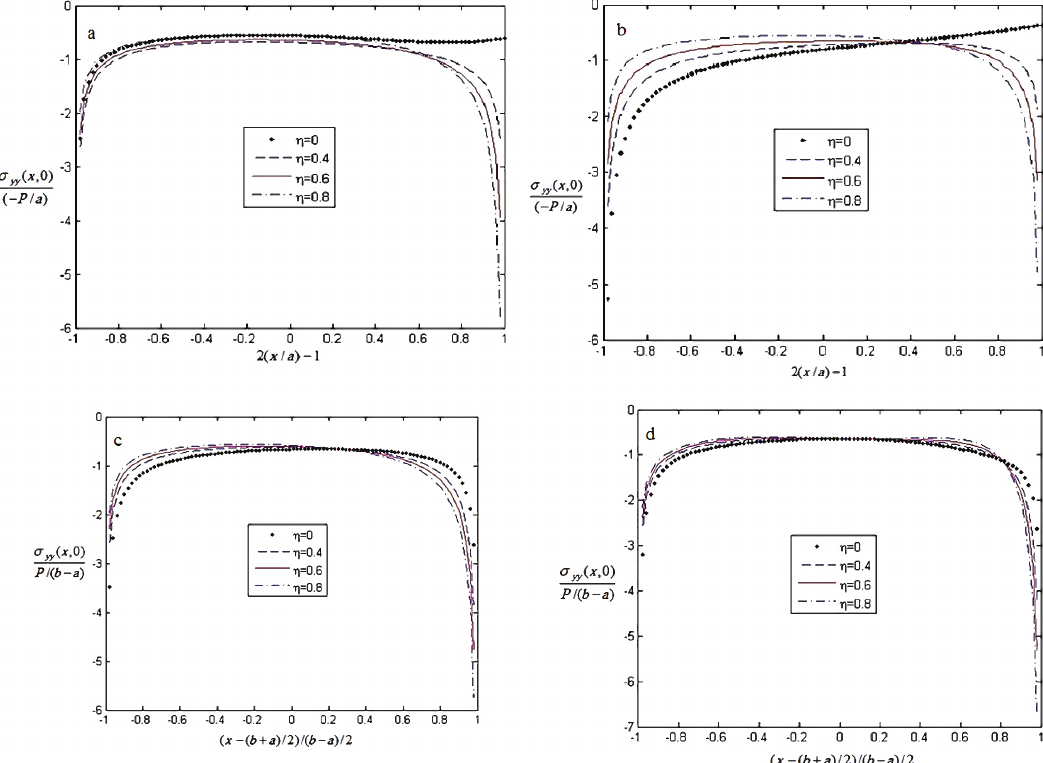
Figure 6. Normalized contact stress distributions computed for various values of the coefficient of friction by considering a flat punch: (a) b=0, υ=0.28, d/a=0.4; (b) b=0, υ=0.28, a/d=0.4; (c) (a-b)/d=1,υ=0.28, b/d=0.4; (d) (a-b)/d=10, υ=0.28,